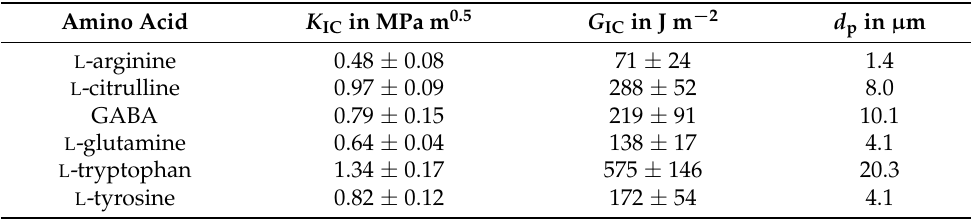
Table 6. Critical stress intensity factor in mode I K IC , fracture energy G IC , and diameter of the plastic zone d p of amino-epoxides (average ± standard